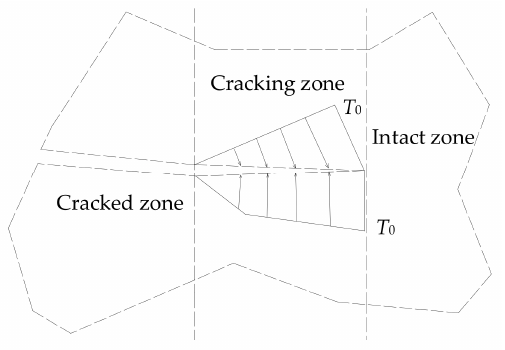
Figure 1. Crack propagation in discontinuous deformation analysis for rock failure (DDARF)